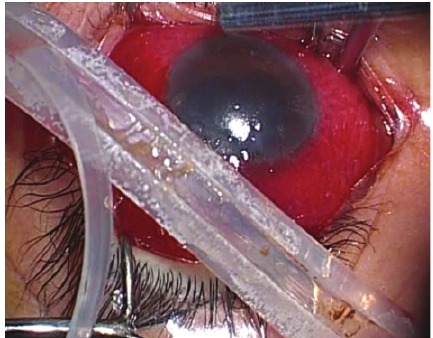
Figure 2: Photograph of the removed buckle. Mucopurulent pus is seen around the